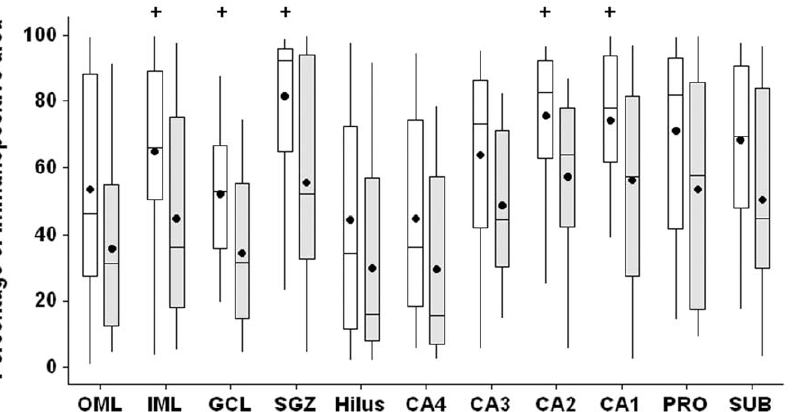
Figure 11. MT-I/II immunopositive area in MTLE patients without and with secondary generalized seizures. Patients without secondary generalization (white boxplots) present increased MT-I/II immunopositivity (p , 0.05) in the inner molecular layer (IML), granule cell layer (GCL), subgranule zone (SGZ), CA2 and CA1, when compared with patients that present secondary generalization (light gray boxplots). The + indicates difference between the